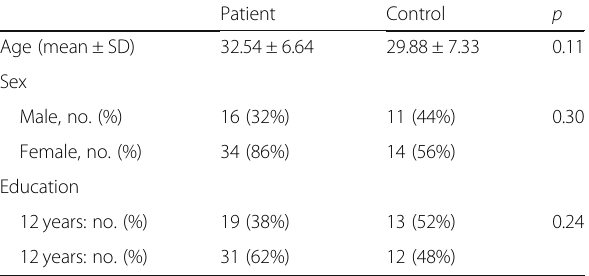
Table 1 Demographic of MS patients and control subjects